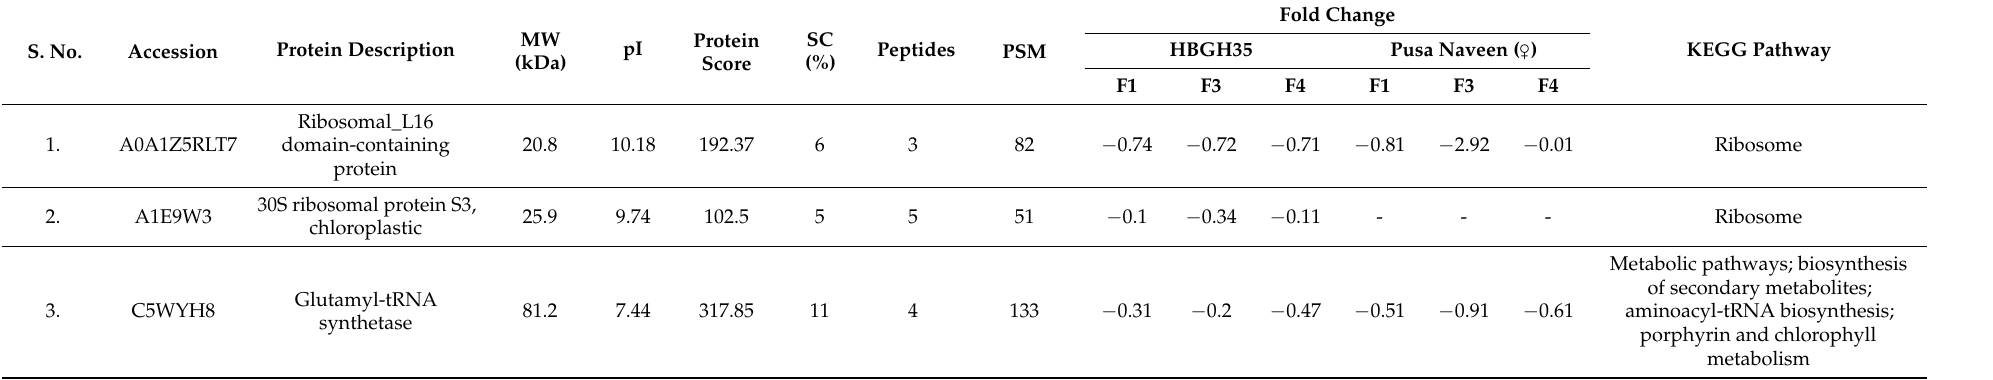
) under different crossing ♀